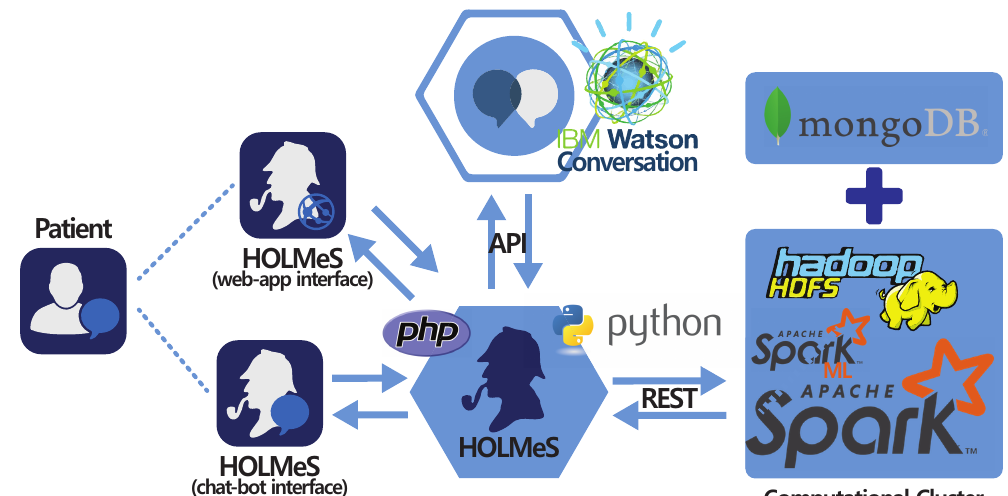
Figure 3. HOLMeS (health online medical suggestions) system main modules with interaction paradigm: At the bottom-centre, the HOLMeS application core; On the left, the HOLMeS chat-bot (bottom) and the patient (top) interacting with HOLMeS; At the top-centre the, IBM Watson conversation logic adopted by HOLMeS through its API; On the right, the computational cluster providing storage, computing, and machine learning services used by